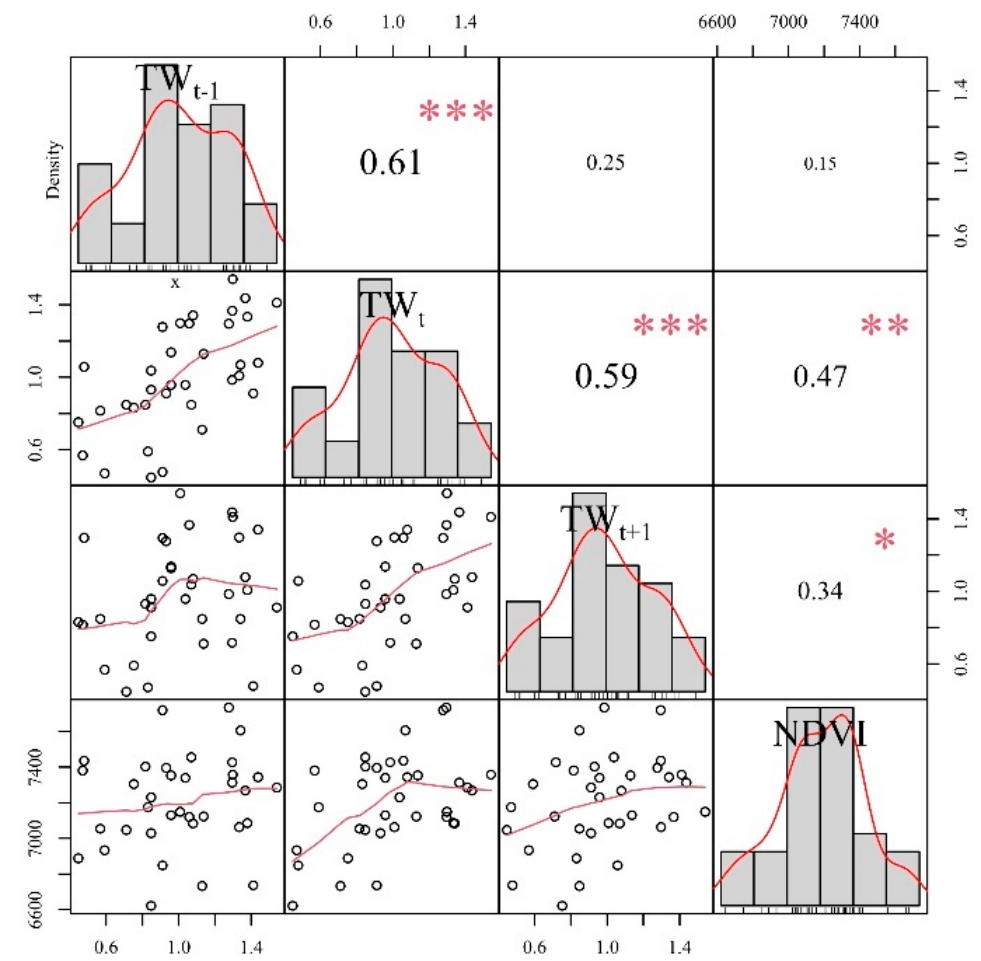
Figure 4. Correlation between the tree-ring index and NDVI. TW t refers to the tree-ring width index of the current year, TW t − 1 refers to the tree-ring width index of the previous year, TW t+1 refers to the tree-ring width index of the next year, the scatter plot refers to the plot of the original data distribution of the tree-ring width index, the bar graph refers to the plot of the frequency distribution of the tree-ring width index, the red line represents its trend, “*”refers to p < 0.05, “**”refers to p < 0.01, and “***”refers to p < 0.001.